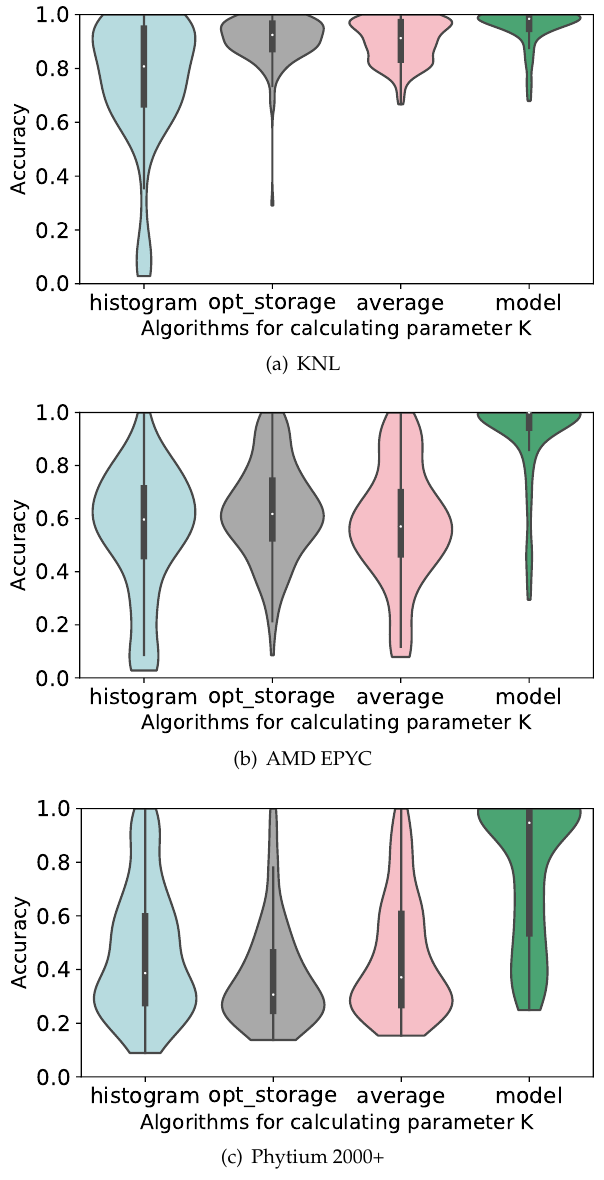
Figure 9. The violin diagram shows the comparison of three methods of obtaining parameter K by showing its corresponding SpMV performance on the three target